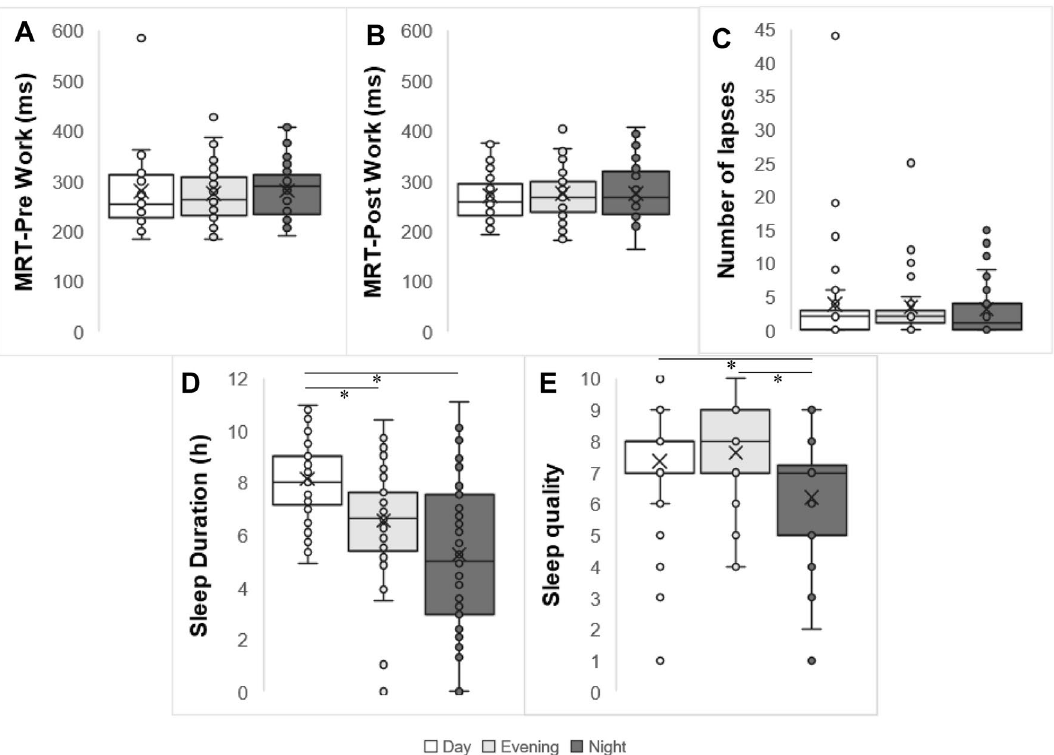
Figure 2. Box plots of the distribution of MRT, number of lapses in attention and sleep duration and quality according to shift. ( A ) MRT pre-work according to shift. ( B ) MRT post-work according to shift. ( C ) Sum of lapses during the shift. ( D ) Sleep duration according to shift. ( E ) Sleep quality according to shift. *Statistical differences, p < 0.001. GLM adjusted for age, BMI, years working in shifts and presence of children at